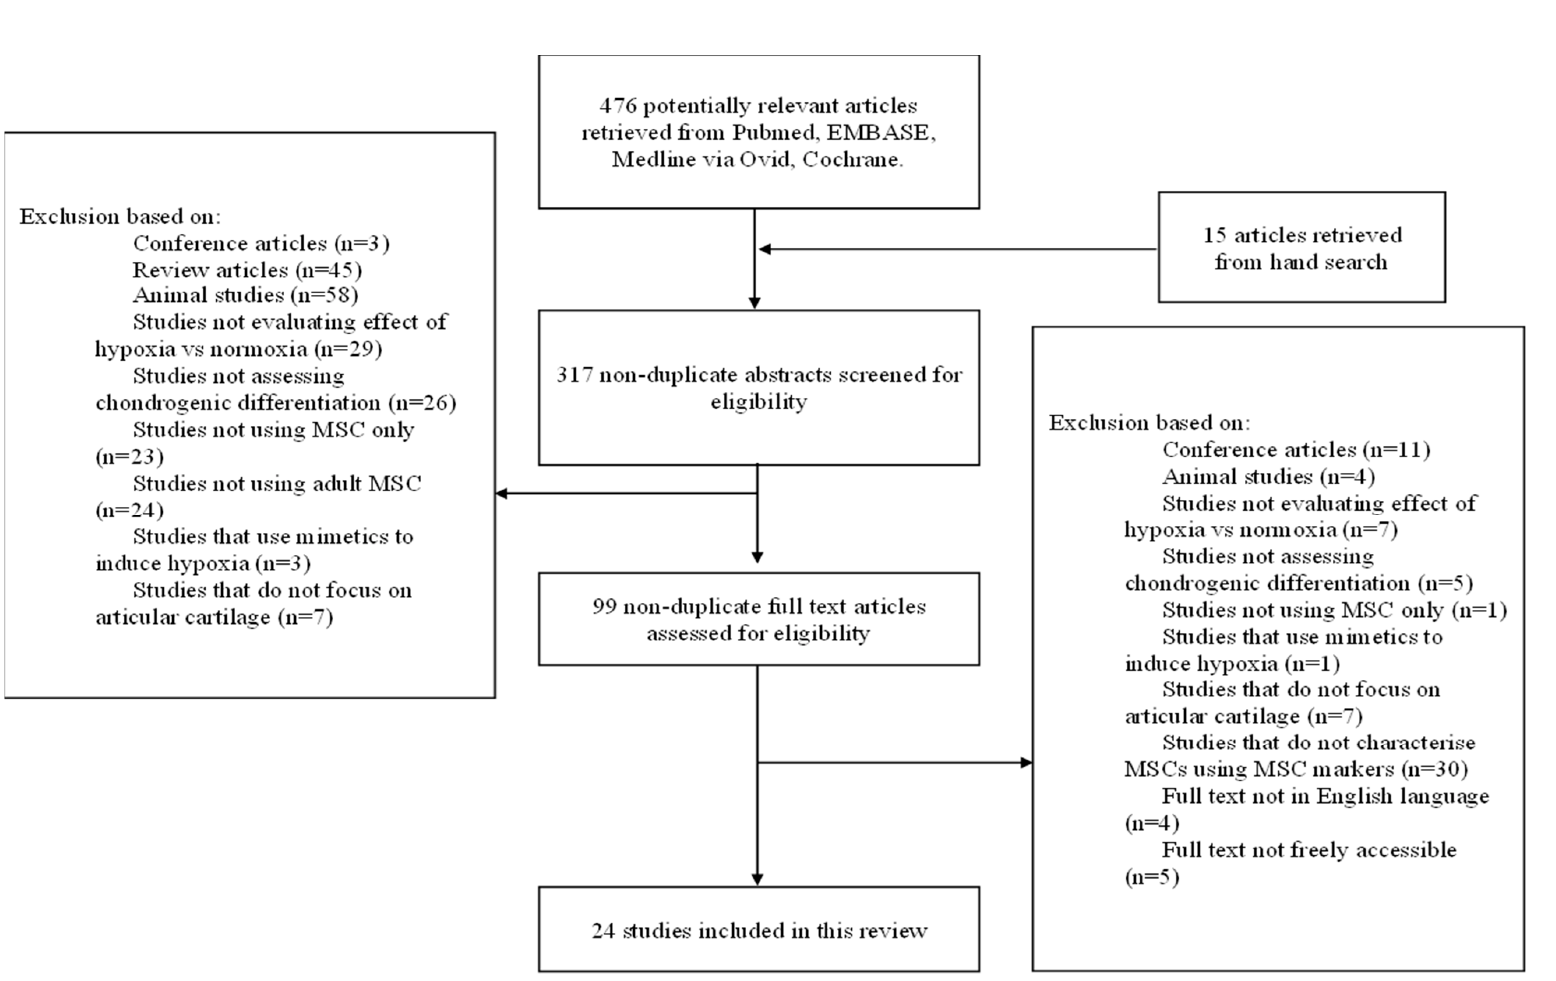
Figure 1. Flow chart showing the process of study selection for inclusion in this systematic review.